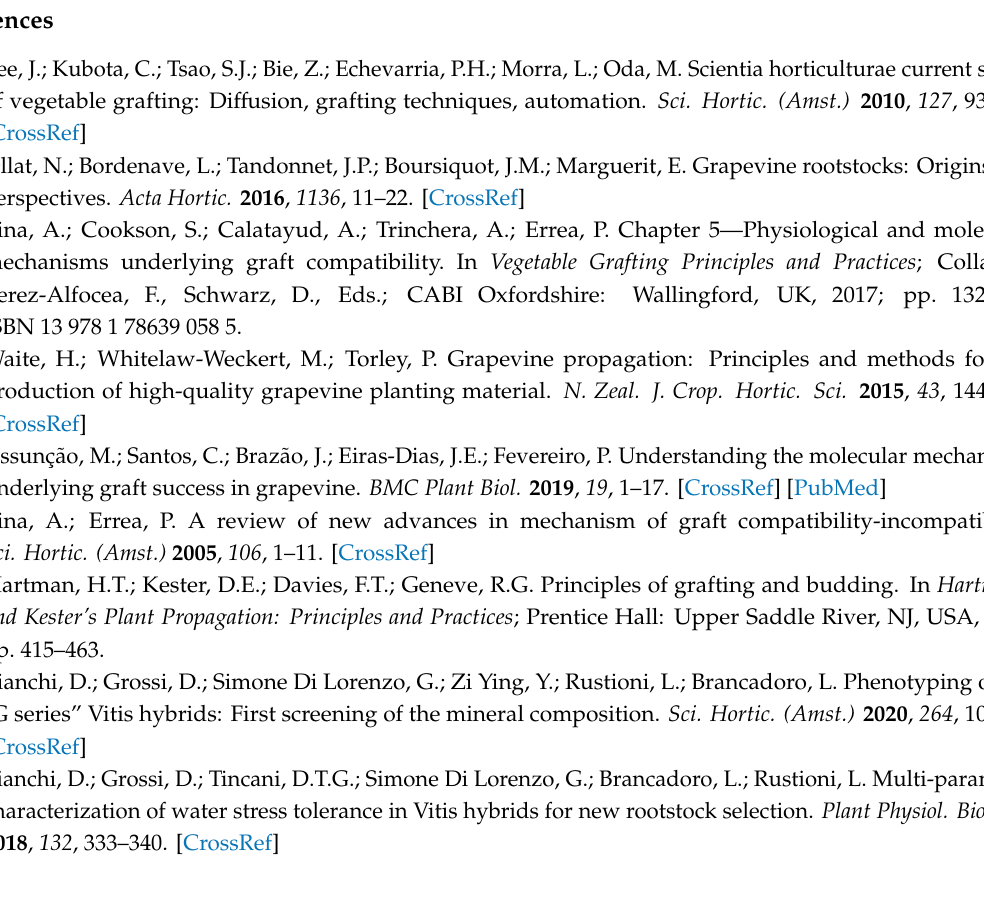
Figure S1: Time course of main climatic parameters (daily means) in the field trial throughout the experiment (May–September 2018). Figure S2: Mean values of Stem Diameter (SD) expansion from 21 to 152 DAG. Table S1: Mean values of the a ffi nity coe ffi cients calculated by the formulas of Parraudine, Branas, Spiegel-Roy and Lavee, and Onaran. Figure S3 : OJIP curves of homo- and